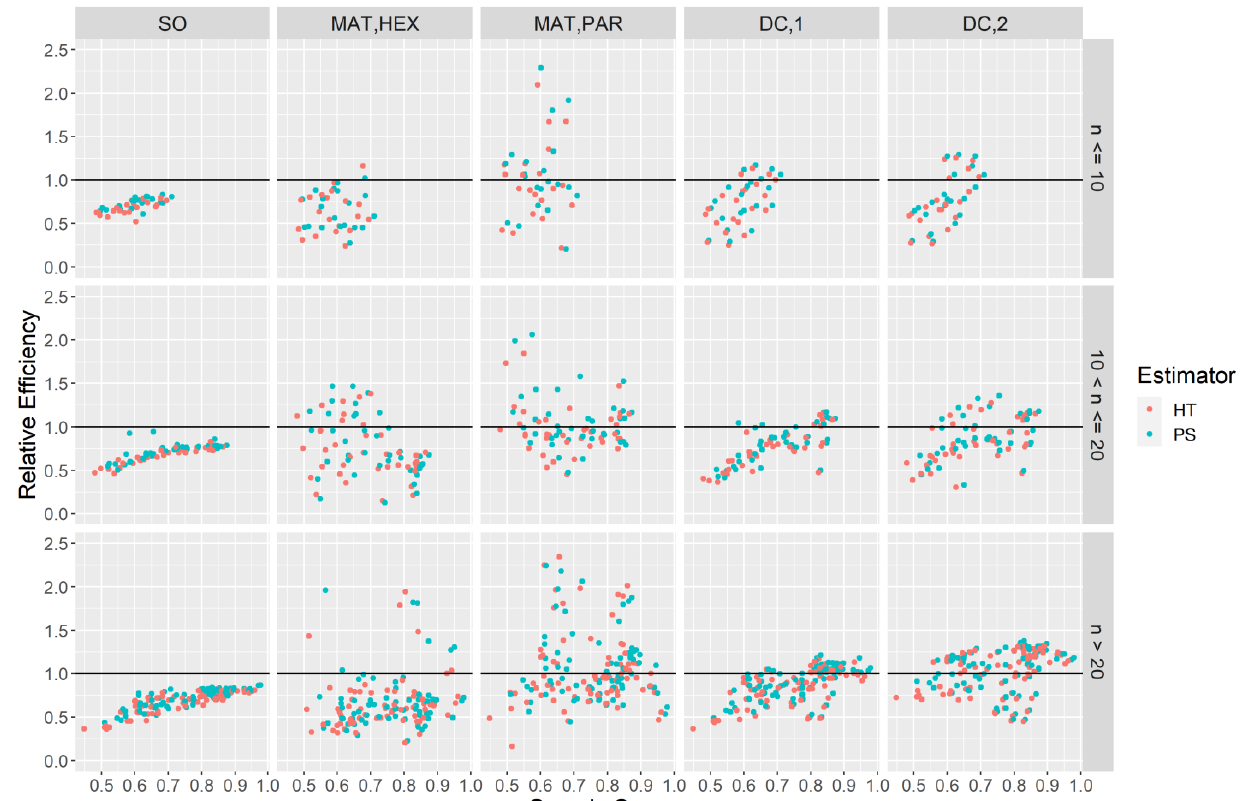
Figure 8. Relative efficiencies of alternative estimators with respect to 𝑉̂ 𝑆𝑅𝑆 for each species-specific attribute within each small domain disaggregated by the small domain sample size class under the HT and PS point estimators.